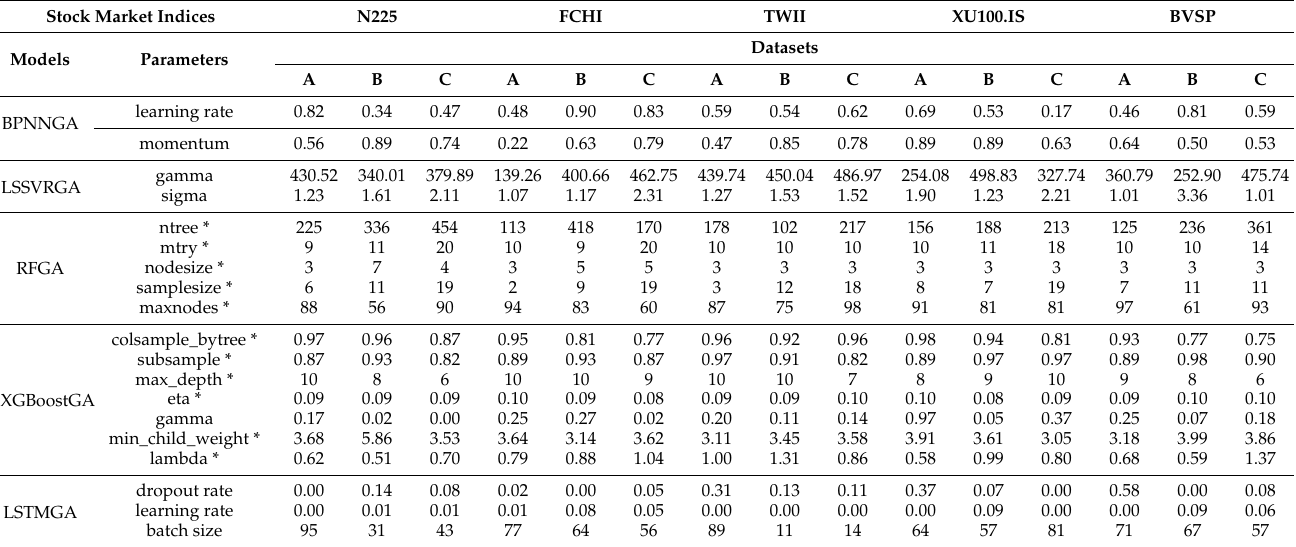
Table 7. Parameters of forecasting models for datasets A, B, and C of stock market indices.